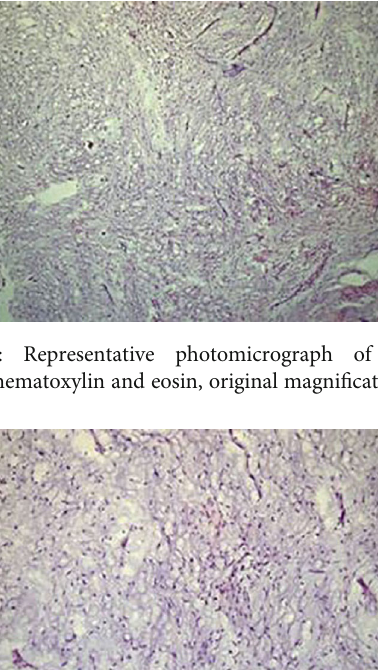
Figure 7: Bone splitting with bone mallet and chisel during implant placement.